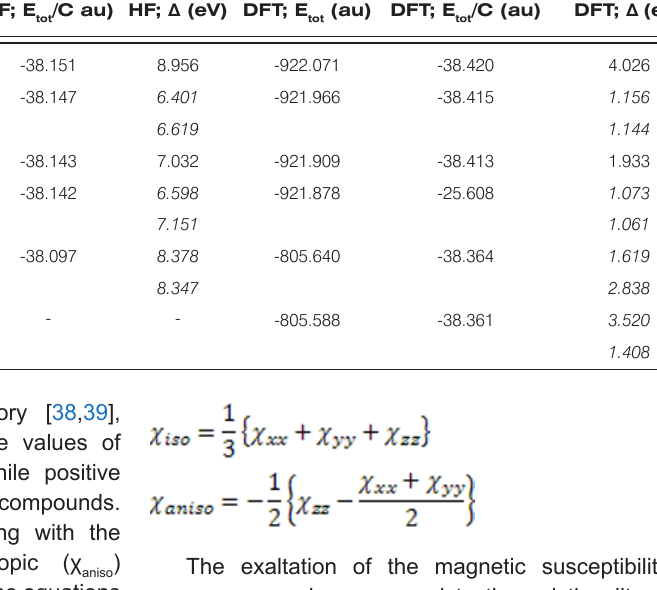
Table 9. The total energies E , total energy per number of C atoms E tot (see text), for the singlet and multiplet states.